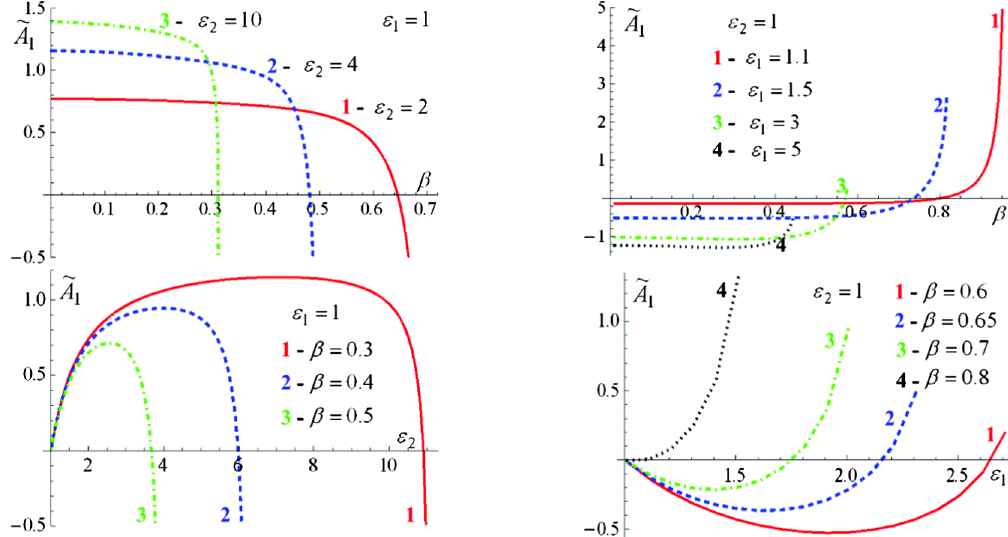
~ A 1 ¼ A 1 a=q 2 on (cid:1) for different values of permittivity " 2 or " 1 (top) and on " 2 or " 1 for FIG. 3. Dependence of the normalized KEG different values of (cid:1) (bottom); the case of " 2 > " 1 ¼ 1 is presented on the left, and the case of " 1 > " 2 ¼ 1 is shown on the right.